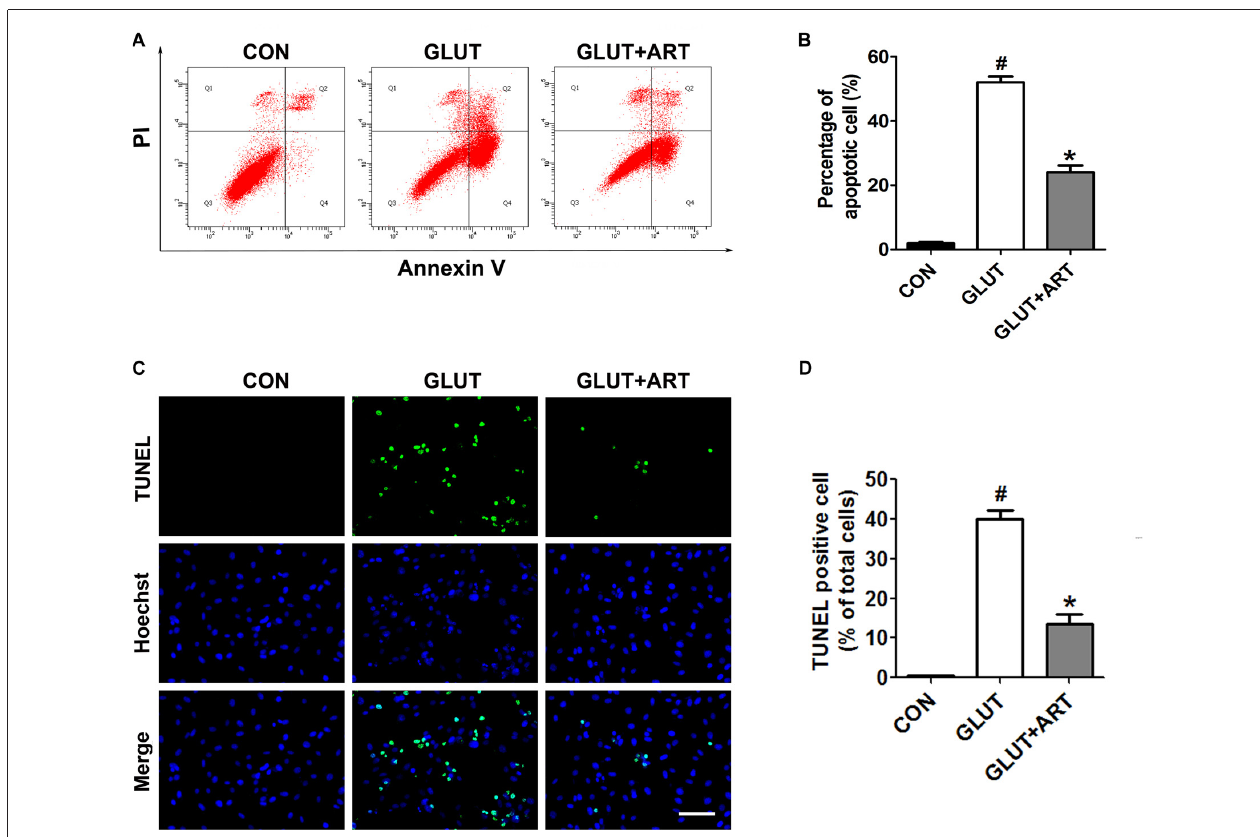
FIGURE 2 | Artemisinin inhibited the glutamate-induced apoptosis in HT-22 cells. (A,B) Flow cytometry analysis indicated the anti-apoptotic effect of artemisinin. (C,D) TUNEL assay manifested that artemisinin attenuated glutamate-induced cell apoptosis significantly. Scale bar = 100 µ m. # p < 0.05 vs. CON group, ∗ p < 0.05 vs. GLUT